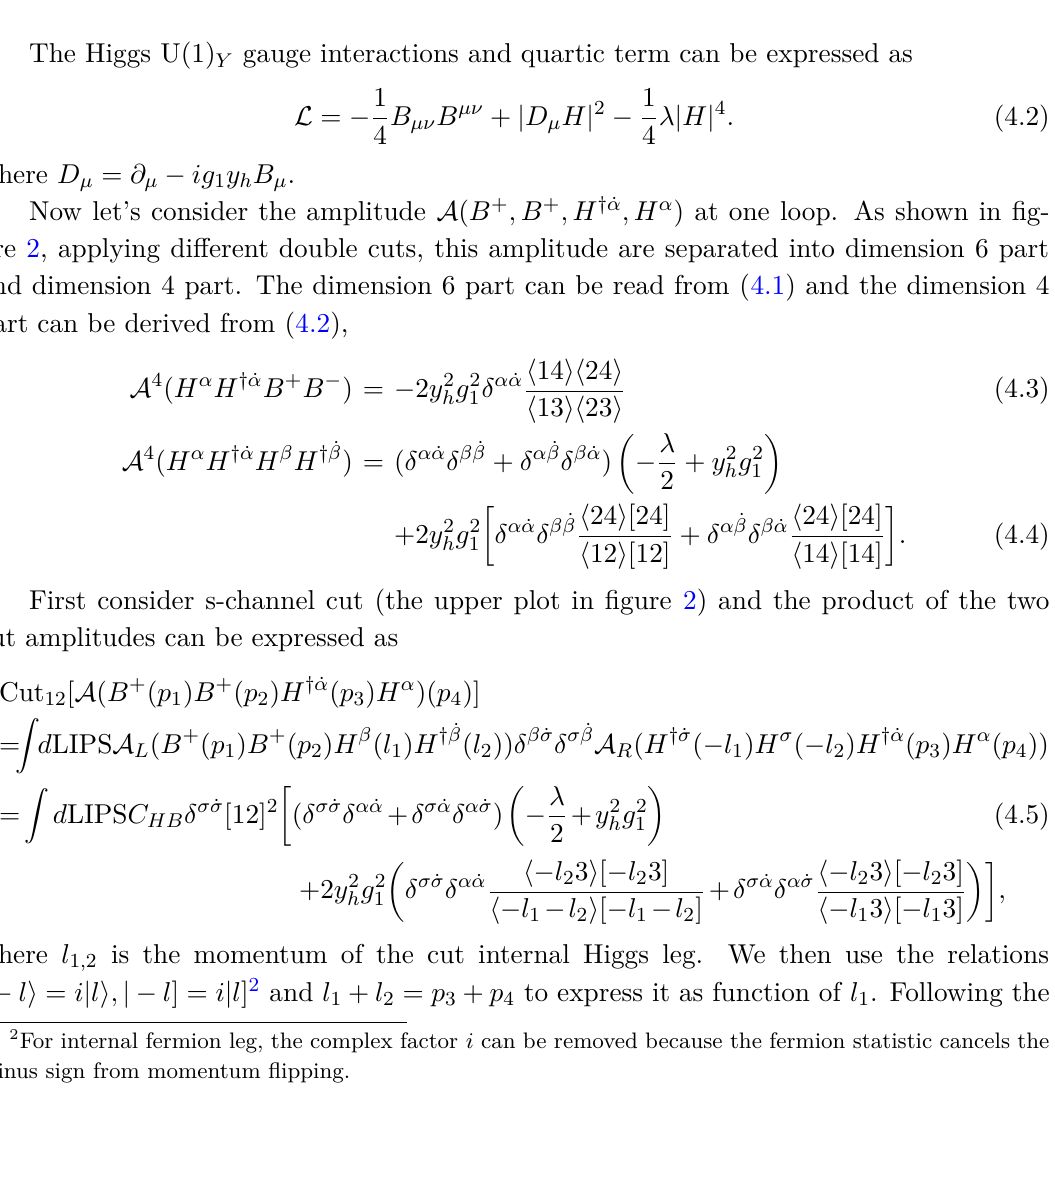
Figure 2 . Unitary cuts in calculating the running of O HB . The upper plot is the s channel cut and the lower two plots are t channel